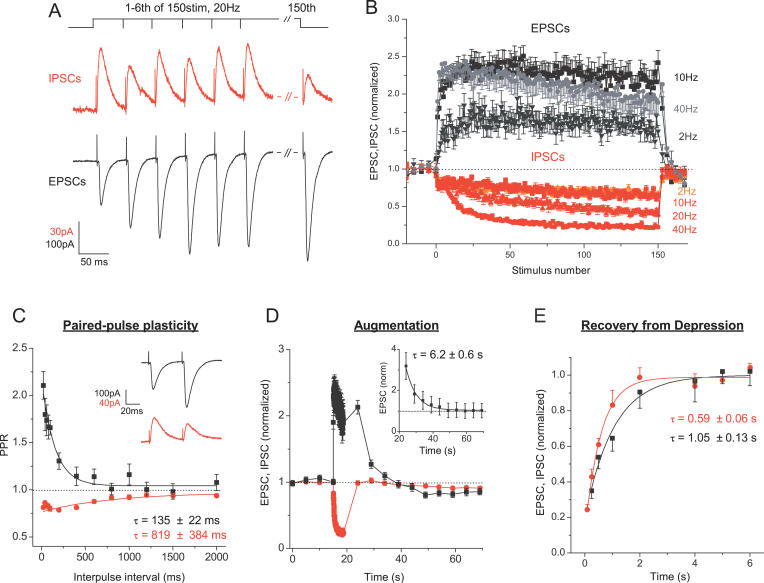
Complementary Expression of STP Components Underlies Opposite Gain Changes of Excitatory and Inhibitory Synapses(A) Top is a representation of the spike train used. Below are whole-cell recordings (current as a function of time) of IPSCs (middle, red) and EPSCs (bottom, black) from two different cells in response to a 150-stimulus, 20 Hz train. First six and 150th responses are shown.(B) Average excitatory (upward going, black) and inhibitory (downward going, red) response amplitudes for 150-stimulus trains at 2, 10, 20, and 40 Hz. Average EPSC response at 20 Hz falls between those at 10 Hz and 40 Hz and is omitted for clarity. Each point is an average of
n = 9–17 cells for EPSCs and
n = 5–9 cells for IPSCs.
(C) Paired-pulse plasticity, measured at intervals 20 ms to 2 s, for excitatory (black) and inhibitory (red) synapses. Inset. Representative excitatory (top, black) and inhibitory (bottom, red) paired responses (current as a function of time) at a 50-ms interval.(D) A mixture of augmentation and the very slow component of depression is unmasked 5 s after the end of 150 stimuli at 40 Hz. Augmentation was extracted from the mixture using the average monoexponential fit parameters of the very slow depression (τ = 49 ± 9 s,
n = 13) and assuming a multiplicative relationship between these components [
44,
45,
58] (inset).
(E) Rapid component of depression was studied with the test pulses applied at different intervals (250 ms to 6 s) after 150 stimuli at 40 Hz for excitatory (black) and inhibitory (red) synapses. For EPSCs, recovery from depression was contaminated mostly by the decaying facilitation and augmentation. Rapid component of depression was isolated from the mixture using the analysis introduced by Magleby and Zengel [
44] and further developed for the hippocampal synapses [
58], assuming multiplicative relationship among the components and using monoexponential fit parameters of facilitation and augmentation determined for each cell as described in (C) and (D).